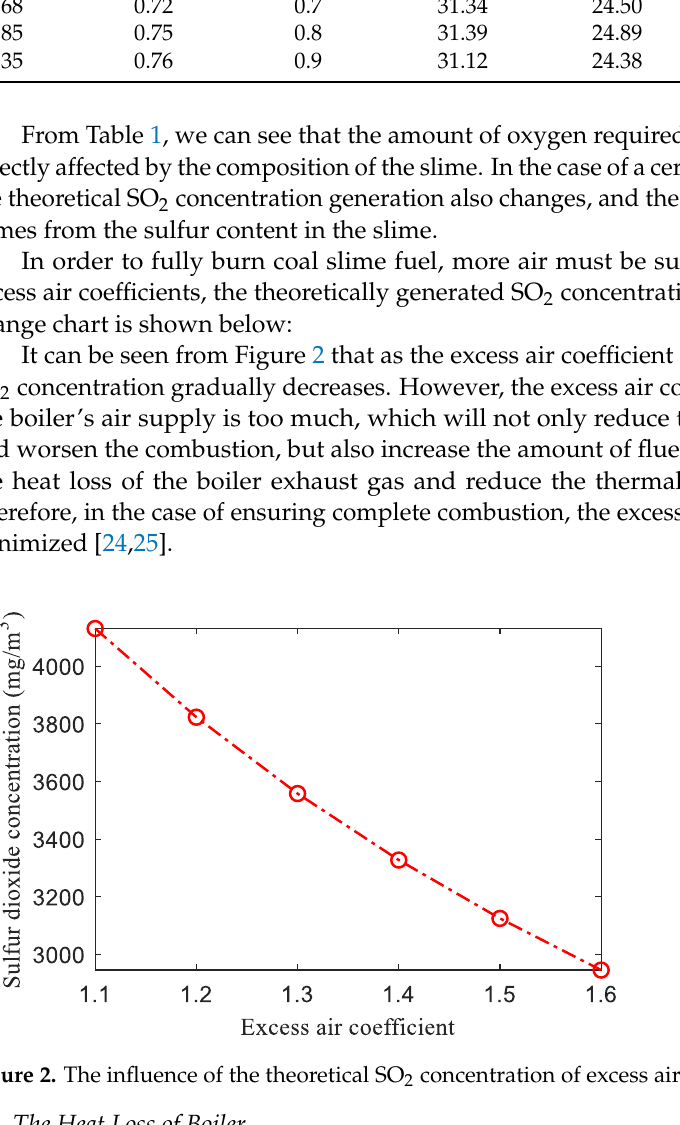
2 concentration of excess air